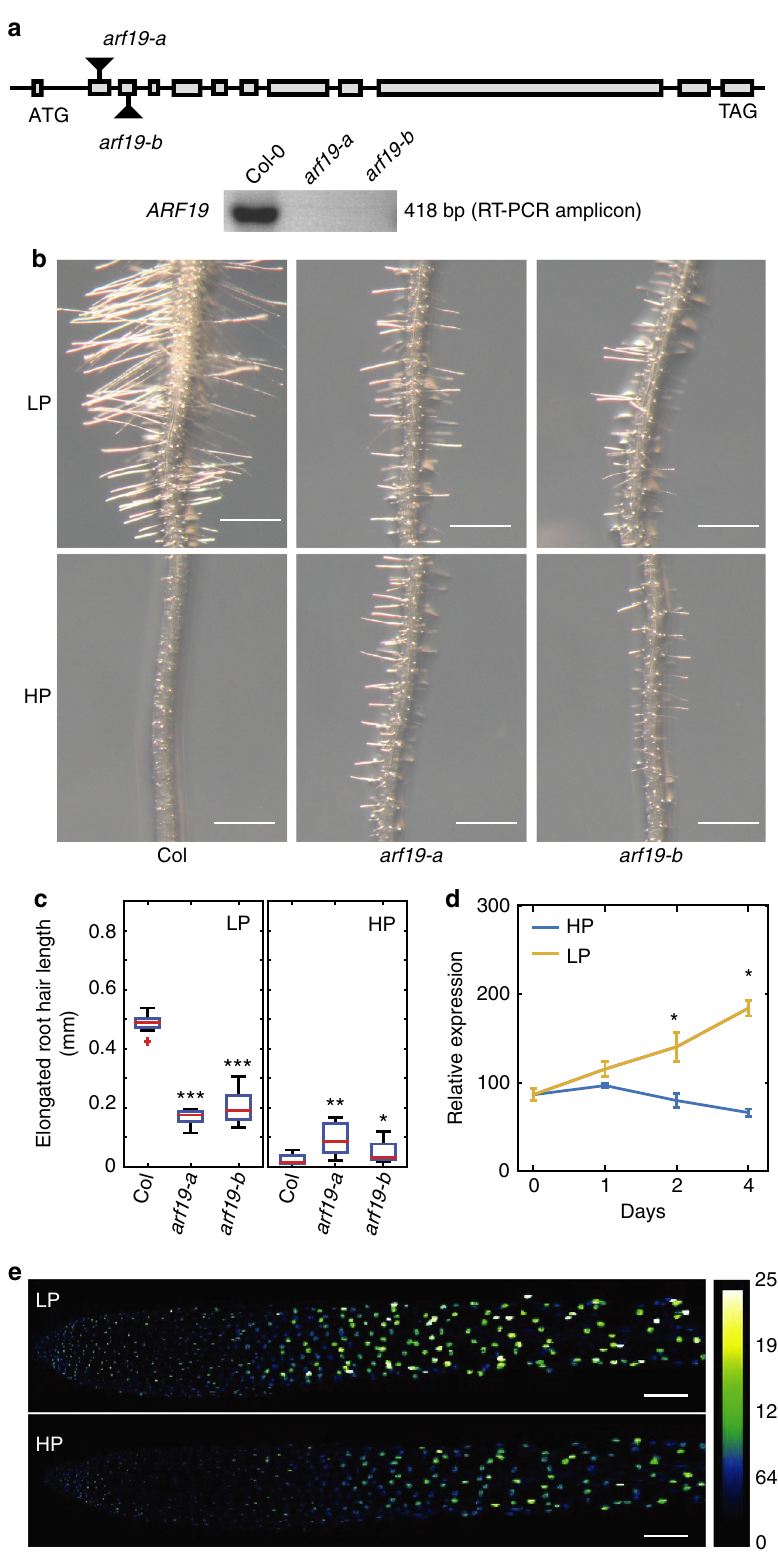
Fig. 4 Auxin Response Factor ARF19 regulates root hair elongation under low P in Arabidopsis . a Cartoon showing positions of two different arf19 mutant alleles used in this study (top) and Reverse Transcription-PCR results showing that arf19-a and arf19-b are null alleles. b Representative images showing root hair growth of Columbia (Col), arf19-a and arf19-b seedlings under low P (LP) or high P (HP) conditions. N = 3, scale bar = 0.5 mm. c Boxplot showing root hair growth of Columbia (Col), arf19-a and arf19-b seedlings under low P (LP) or high P (HP) conditions. *, **, and *** indicate signi fi cant difference ( q - value < 0.005, 0.0001, and 0.00001, respectively) judged by Student ’ s t -test. d Expression pro fi ling studies showing ARF19 expression under low P (LP) or high P (HP) conditions. *Indicates signi fi cant difference ( q -value < 0.05) judged by Student ’ s t -test and after Benjamini and Hochberg false discovery rate correction). e Fluorescence intensity of pARF19::3XVENUS-NLS seedlings grown under low P (LP) and high P (HP). N = 3, scale bar = 100 µ